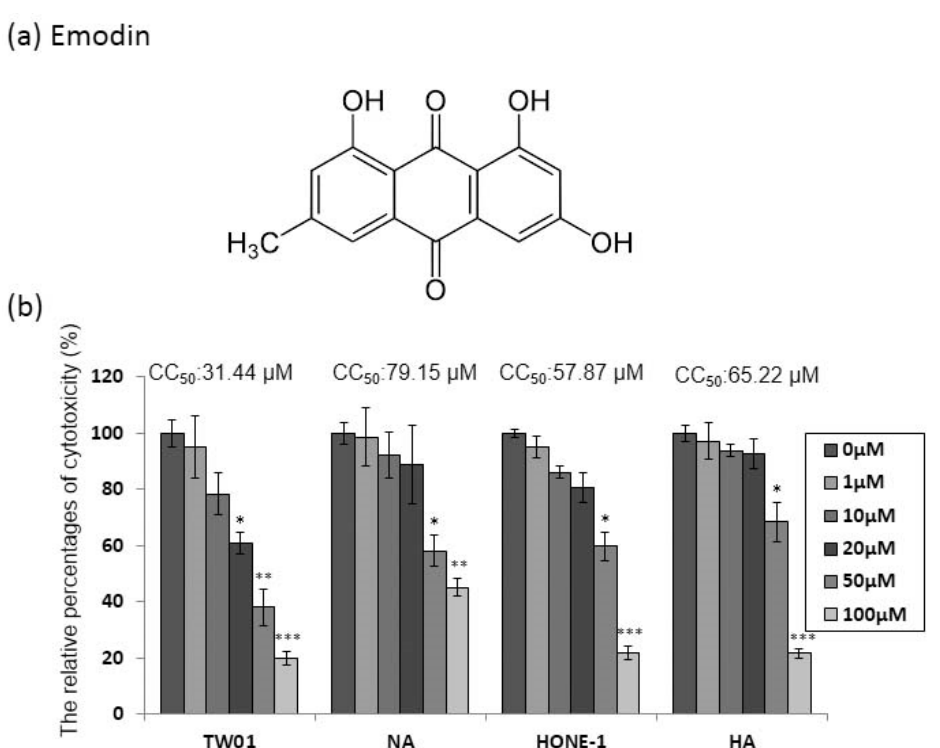
Figure 1. Epstein-Barr virus (EBV) positive nasopharyngeal carcinoma (NPC) cells are more resistant to emodin. ( a ) The chemical structure of emodin. ( b ) NPC cell lines (TW01, HONE-1) and their EBV infected counterparts (NA, HA) were treated with indicated concentrations of emodin for 48 h, followed by cell viability assay and CC50 calculation (top of each panel). The values are means ± SD from at least three independent experiments. (* p < 0.05, ** p < 0.01, *** p < 0.001 compared to the group of 0 μ M).